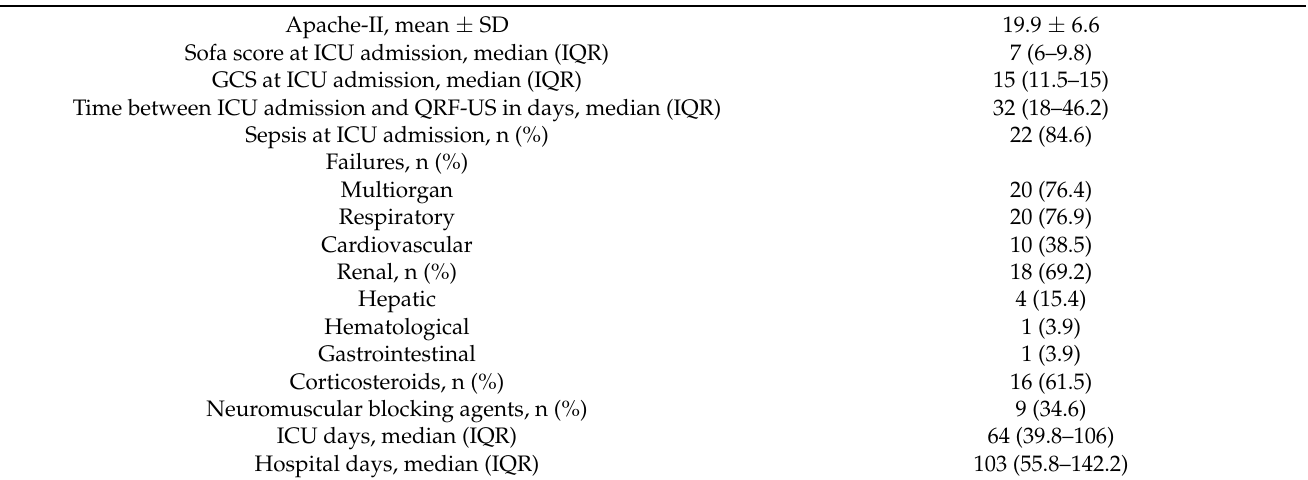
Table 2. Patients’ clinical characteristics.